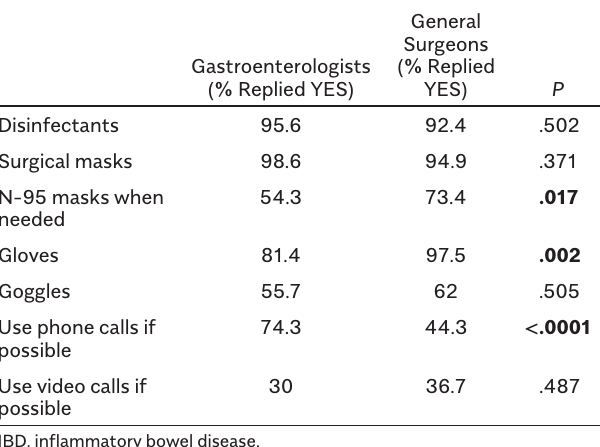
Table 2. Protective Measurements Taken During this Pandemic when Seeing IBD